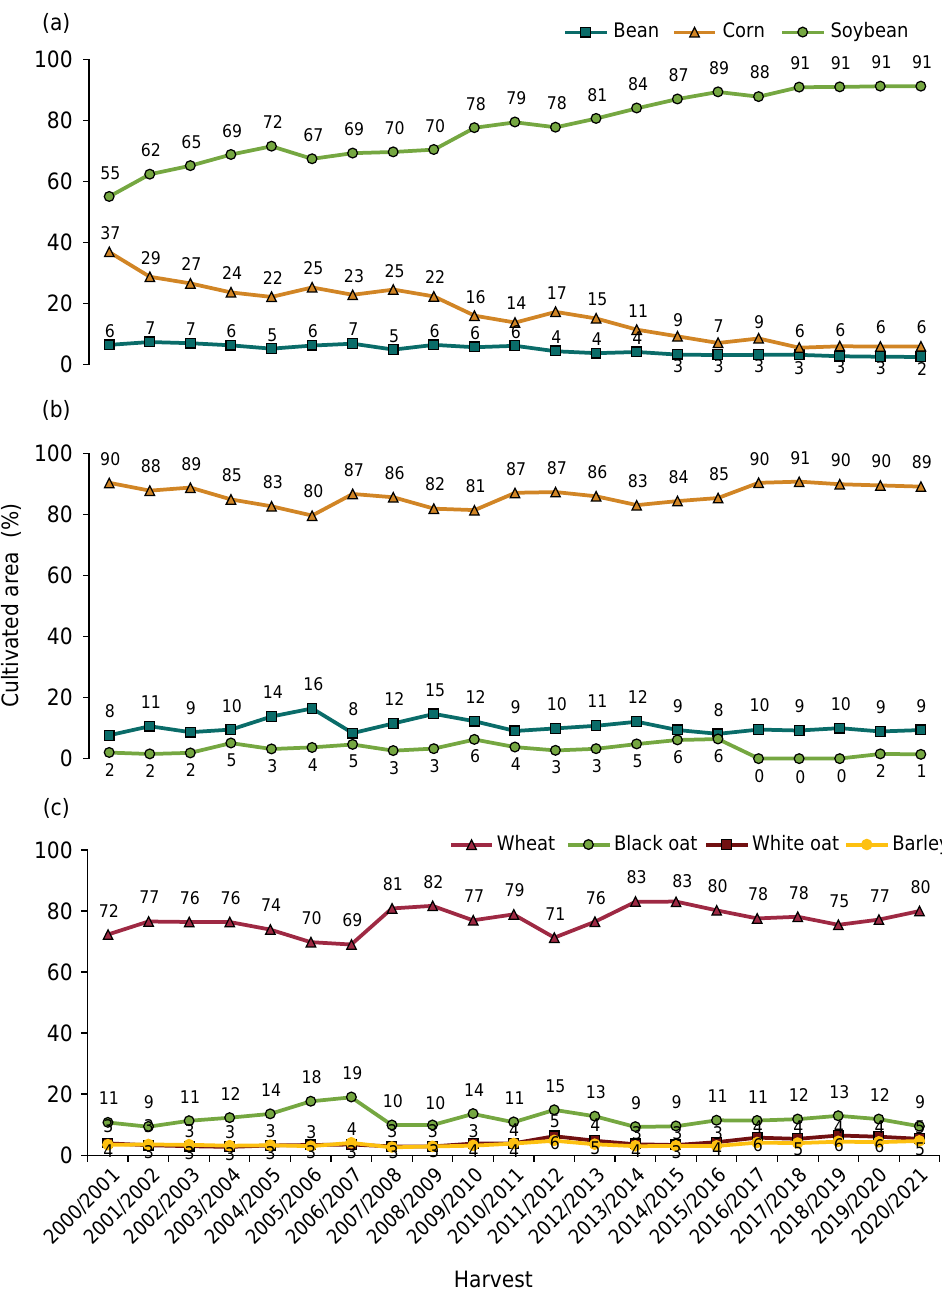
Figure 1. Evolution of the percentage of the cultivated area with the main annual crops in Paraná State among agricultural years 2000/2001 and 2020/2021, referring to the first crop (a), second crop (b) and third crop (c). Source: Paraná